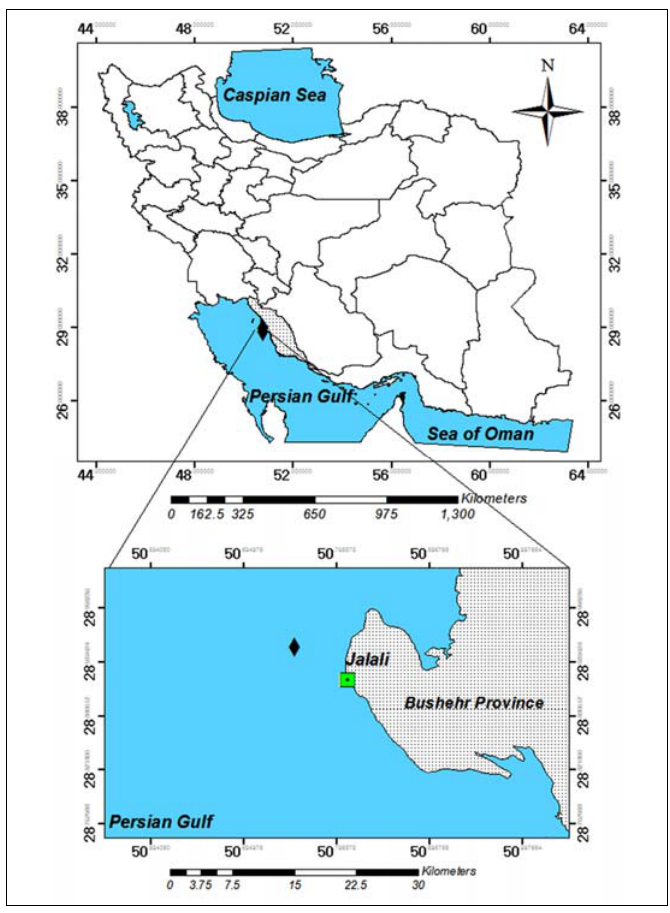
F IGURE 1. Sea cucumber collection site in Persian Gulf, Bushehr harbor . Samples were sieved over a 0.5 mm mesh-sized sieve and stained with Rose Bengal. Later on, individuals preserved with ethanol 70%. Dried specimen was photographed. For exact identification, small sections of tissue from the body wall (mid-body wall, anterior and posterior body wall) was sampled and dissolved in household bleach, Washed three times with distilled water (three times) and with ethanol 96% (two times), air-dried. The extracted ossicles were studied by light microscopy and photographs and measurements of the ossicles were